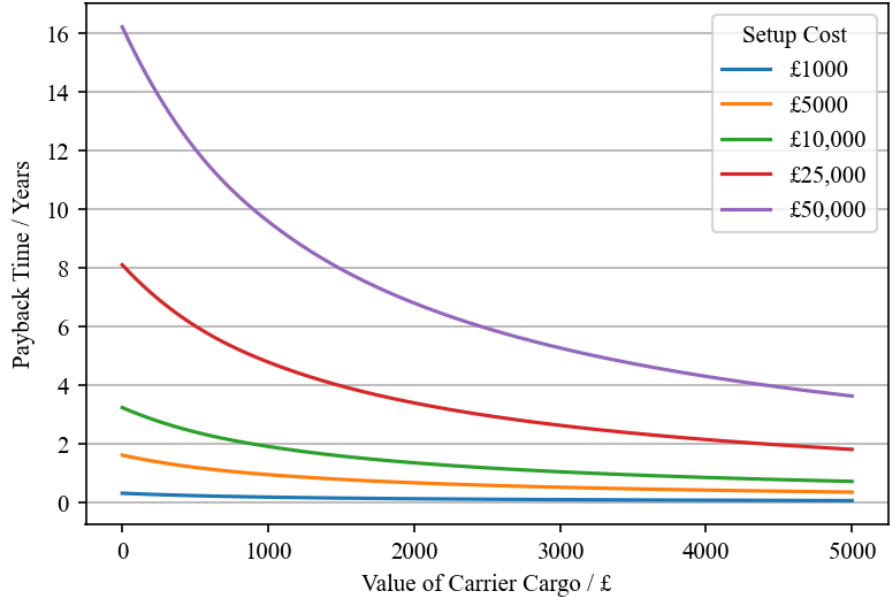
Figure 9. A figure showing how payback time varies for different values of carrier cargo for different setup costs, which is relevant for scenario 1 of the case study chosen for this work. Table 6. Fixed values used in Equation (6) relating to scenario 1 for the chosen case study of beef distribution in the UK. Note that the cost of IoT hub, C h is zero. In the worst case scenario, where all Carriers are all out for delivery and transmitting data, the required number of messages per day still falls within the free tier of the Azure IoT